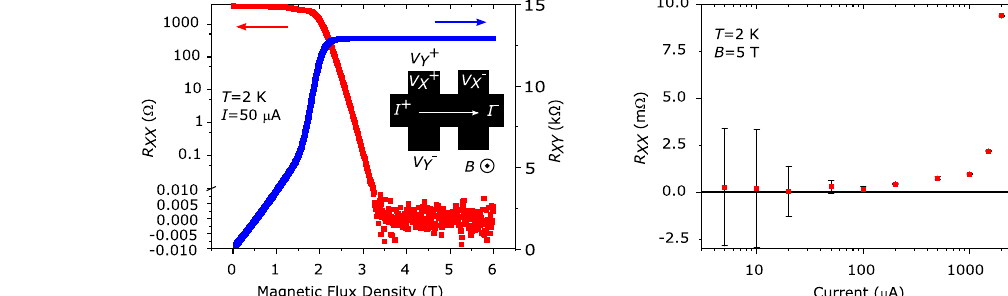
the array carrier density and mobility. The Hall bar schematic in the inset shows how resistances are measured. Current I X issent between contacts named I + and I - . R XY is measured using contacts named V Y + and V Y − as R XY =V Y /I X , while R X X is measured between V X + and V X − as R XX =V X /I X . b Breakdown current measured on the Hall bar reveals no signi fi cant increase in R XX up to 100 μ A bias. Error bars represent one standard